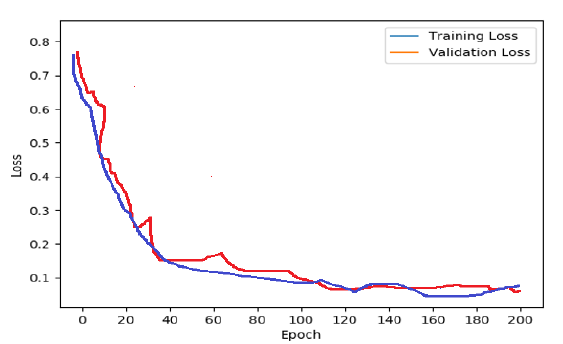
Figure 14. Training and Validation loss (VGG16).